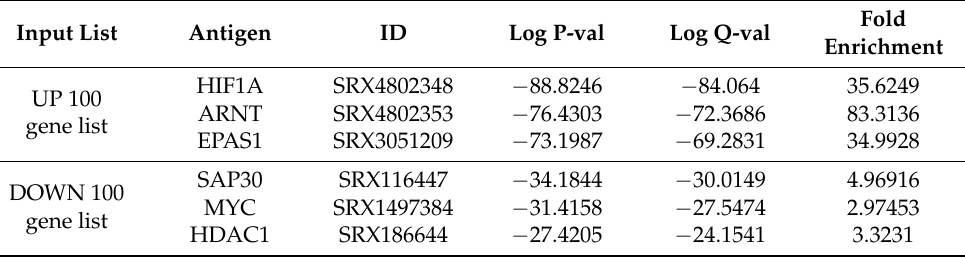
Table 1. The result of enrichment analysis in ChIP-Atlas. Enrichment analysis in ChIP-Atlas is a search tool for target genes and colocalizing factors of a given transcription